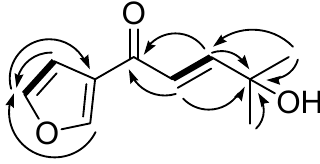
Figure 3. Key 1 H- 1 H COSY ( ▬ ) and 1 H- 13 C HMBC ( → ) correlations of 1 .